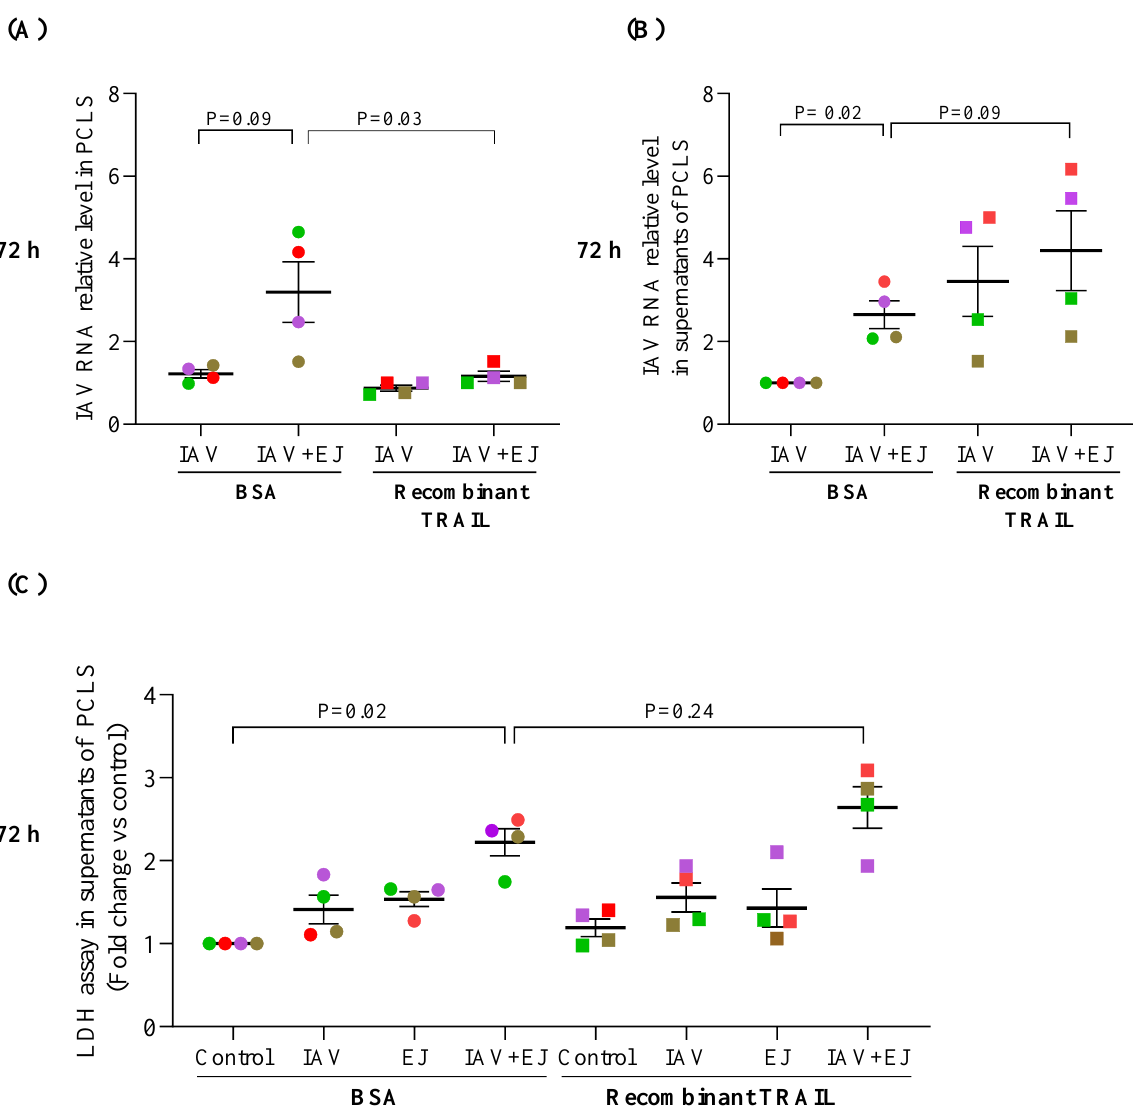
Figure 4. Recombinant TRAIL altered influenza A virus (IAV) infection in human precision-cut lung slices (PCLS). PCLS were treated with IAV and E-juice (EJ) in the presence or absence of BSA (control) and recombinant TRAIL (10 ng/mL) for 72 h. IAV load in lung tissue ( A ) and supernatants ( B ) was analyzed by RT-PCR. Cytotoxicity ( C ) was analyzed by the LDH assay. Each data point (colored dot) represents the average of 3 replicates from each respective individual donor ( n = 4 donors). Horizontal lines indicate mean ± SEM. Paired t -test was used to analyze the data.